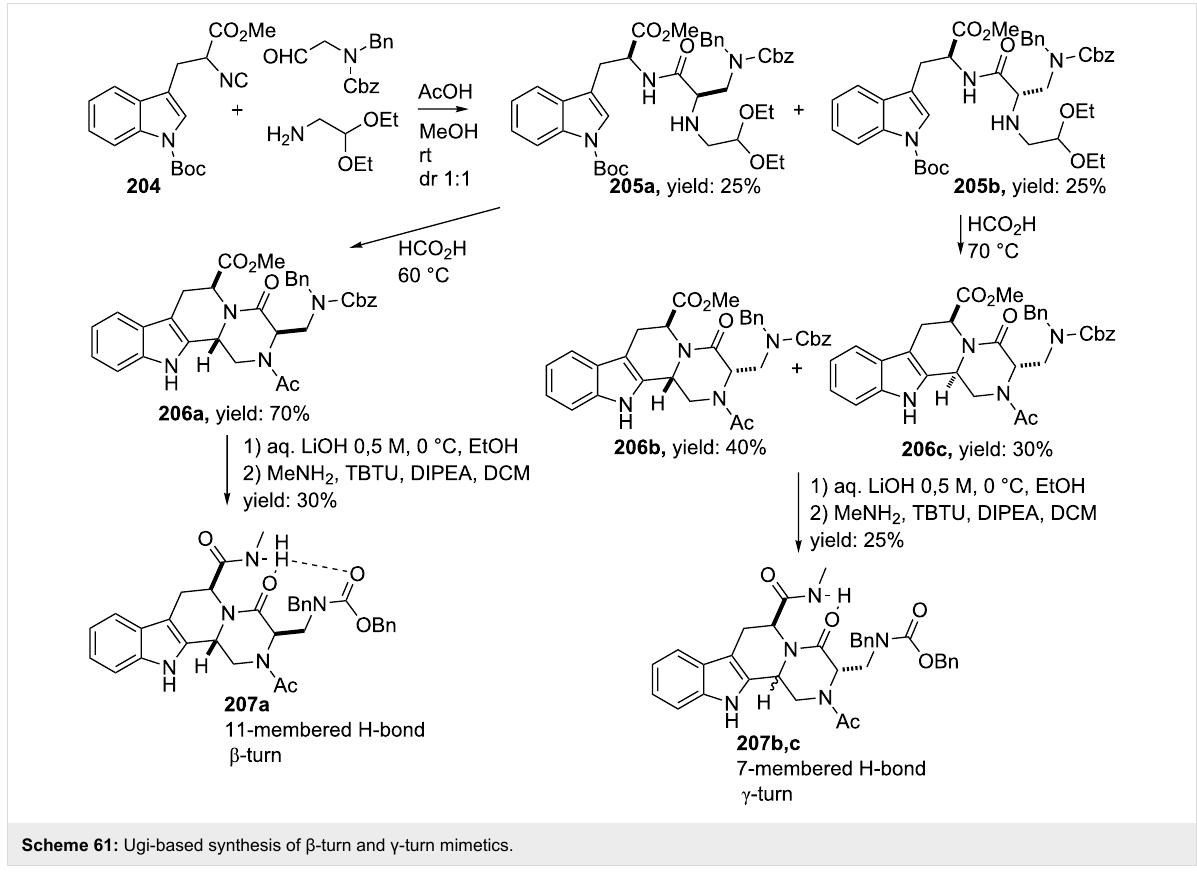
Scheme 61: Ugi-based synthesis of β -turn and γ -turn mimetics.